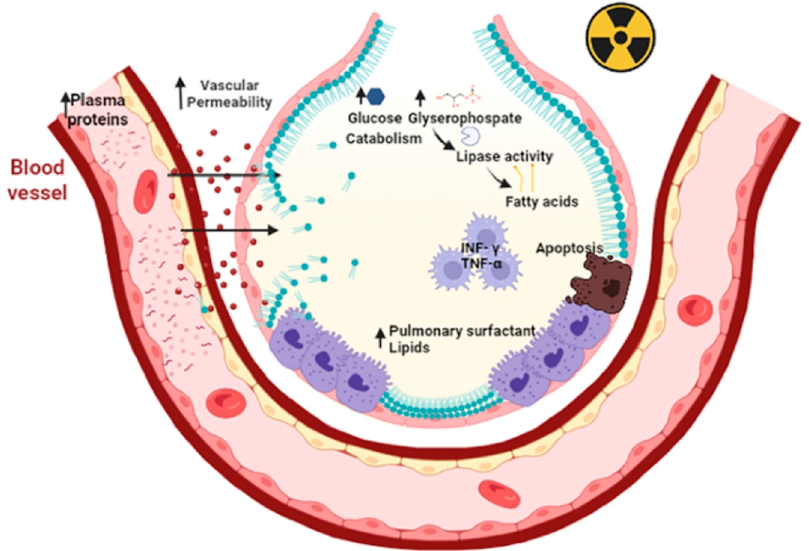
Figure 3. Primary radiation increases microvascular permeability and plasma proteins that over- whelm the drainage mechanisms. This elicits a secondary response to hyperplasia of type II epithelial cells. In addition, there is an accumulation of pulmonary surfactant within the alveolus that triggers apoptosis of type II epithelial cells, oxidative damage and the release of fibrotic cytokines such as TNF- Υ and TNF- α . Primary radiation increases the catabolism of lipoprotein lipases due to in- creased glucose and glycerophosphate. This results in the release of fatty acids leading to decreased distensibility and respiratory failure. Figure created in BioRender.com.